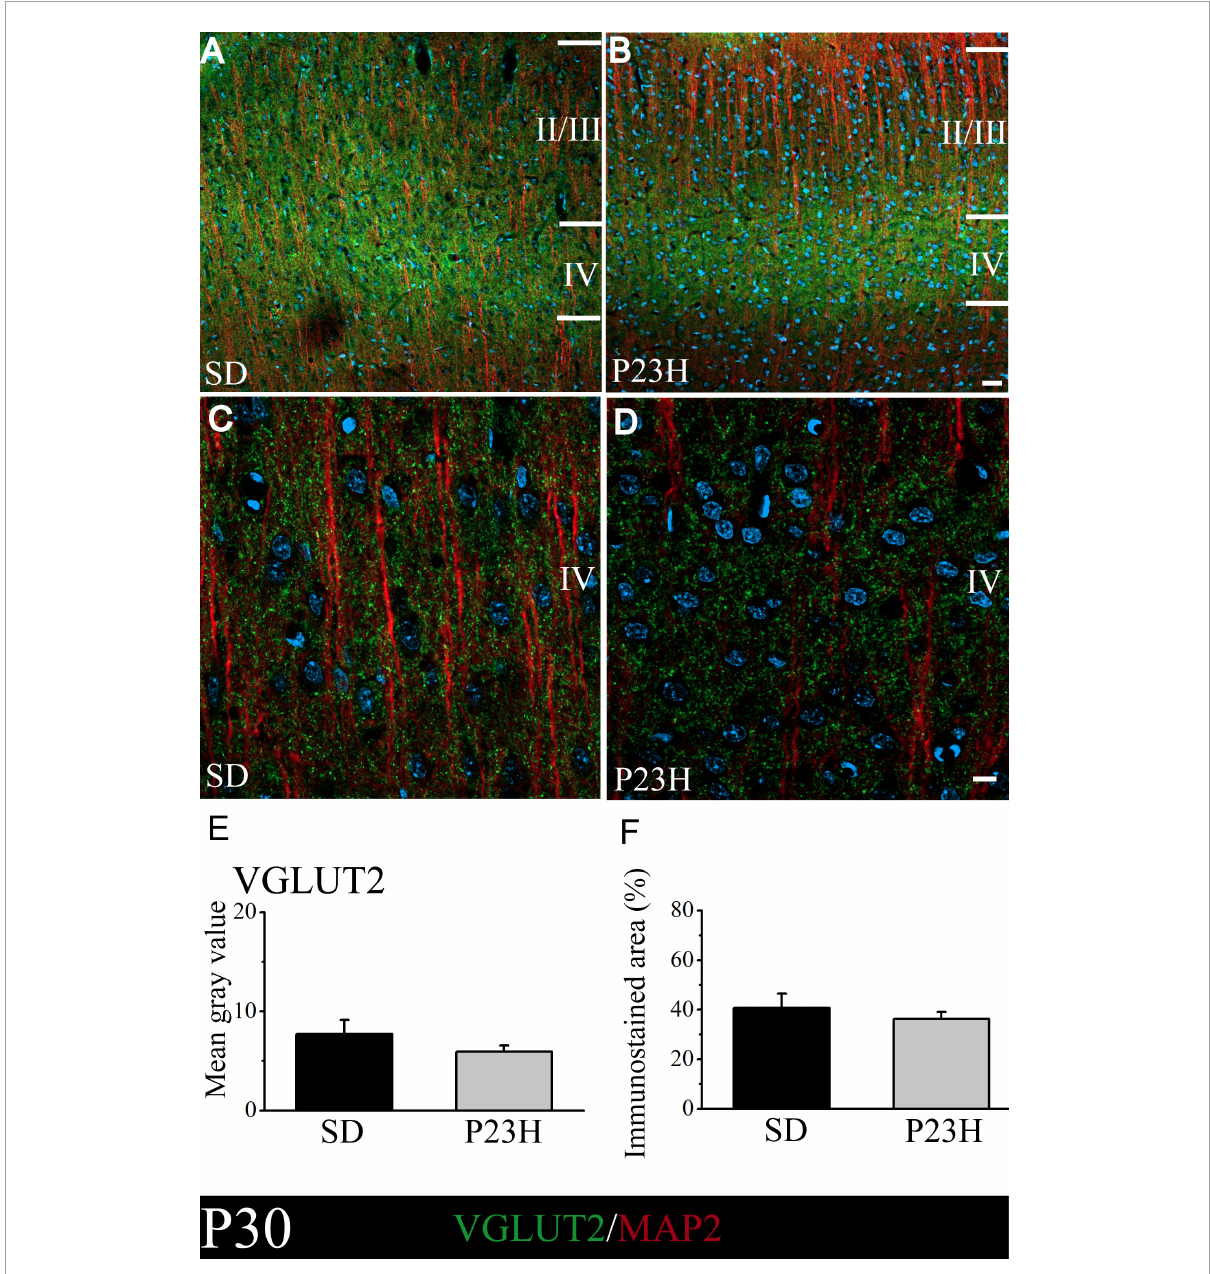
FIGURE4 VGLUT2 and MAP2 immunolabeling in the visual cortices of the SD and P23H rats at P30. (A,B) Confocal images of the VGLUT2-ir thalamic presynaptic structures (green) and MAP2-ir somata and dendrites (red) along layers II/III and IV of the visual cortices of the young SD and P23H rats. Nuclei are counterstained with DAPI (blue). Note a well-defined and narrower VGLUT2-ir band in P23H. (C,D) High-magnification confocal images of VGLUT2 and MAP2 immunolabeling of visual cortical layer IV. (E,F) Quantification of the MGV and % of immunostained areas. No statistically significant differences were found between both conditions. Scale bar: 25 µ m (A,B) ; 10 µ m (C,D)